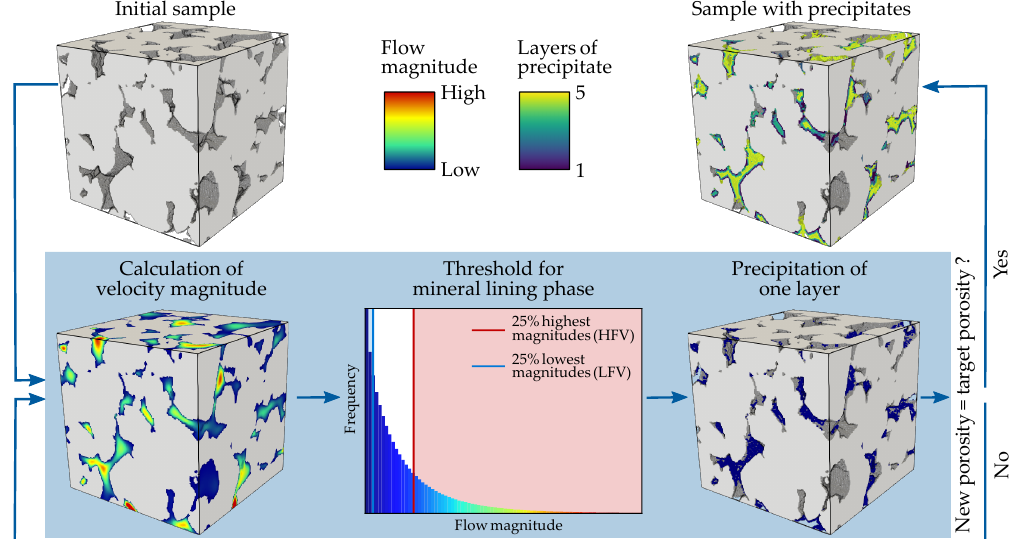
Figure 3. Schematic workflow of the iterative velocity-dependent precipitation process: A threshold is calculated based on the initially simulated magnitude of flow velocities. The grain-lining voxels comprising the 25% highest (HFV) or 25% lowest (LFV) flow velocity magnitudes are converted from void to mineral. Then, the flow field is calculated for the new microstructure, and the process is repeated until a pre-defined porosity is achieved or the digital sample becomes